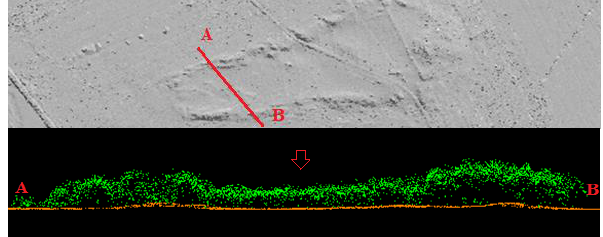
Figure 11. Microstructure in forest area – elevation profile A-B – object 5